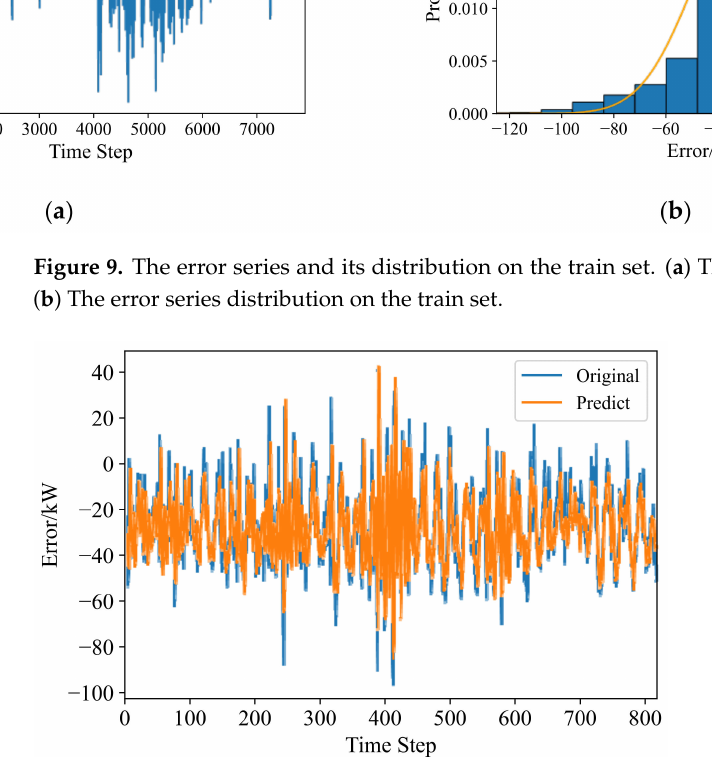
Figure 10. The actual and forecasted error on the train